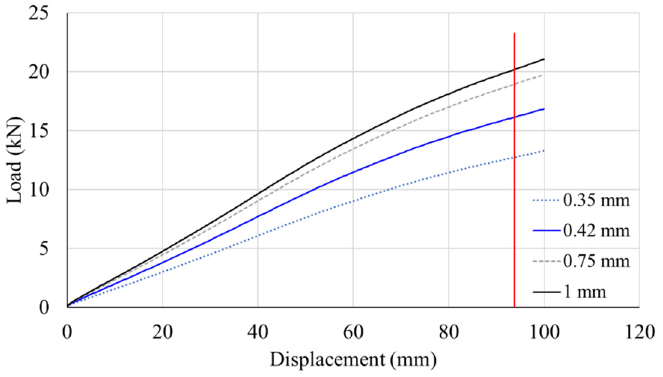
Figure 9. Load–displacement curves for decks of varying thickness of the corrugated base sheet.